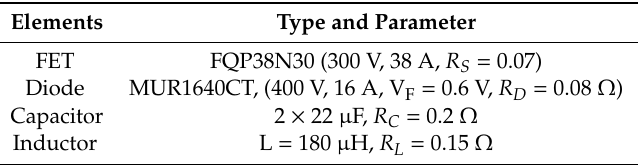
Table 5. The parameters of the circuit.